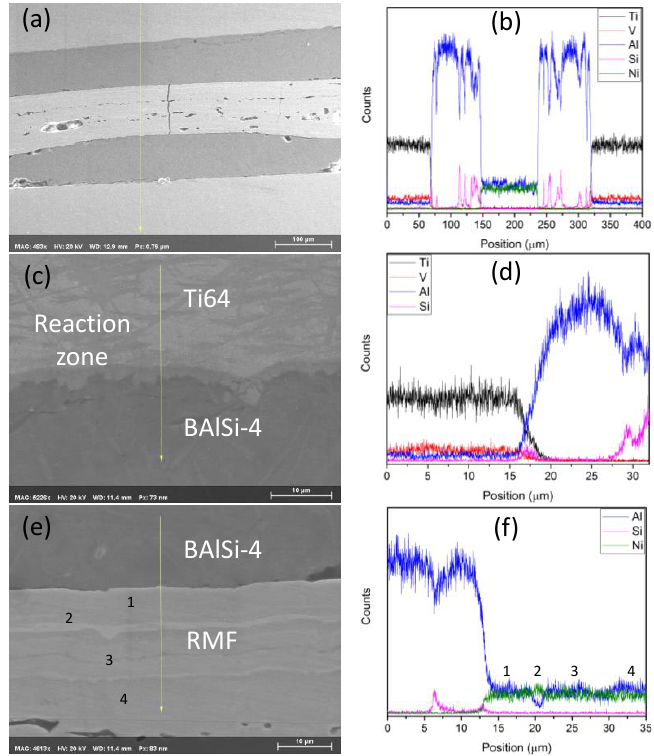
Figure 6. EDS line scan of ( a , b ) the entire brazed joint, ( c , d ) theTi64-BAl interface, and ( e , f ) BAl-RMF interface with select point analysis.